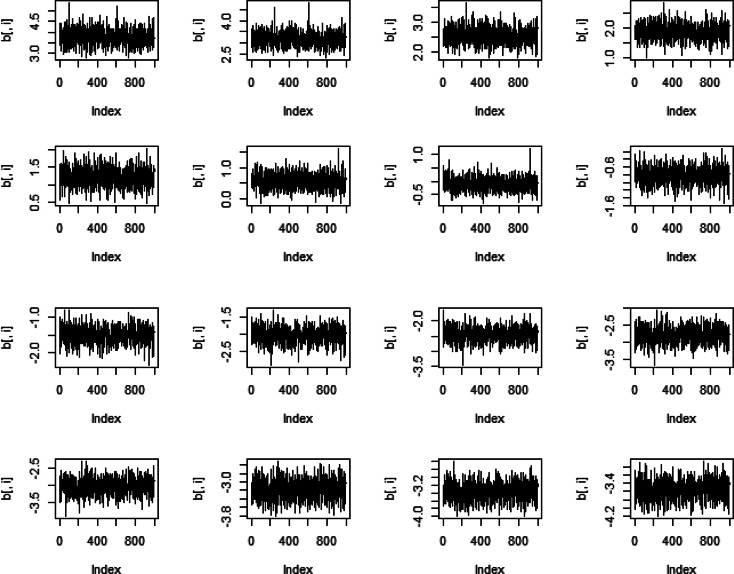
Trace plot for some of the parameters.